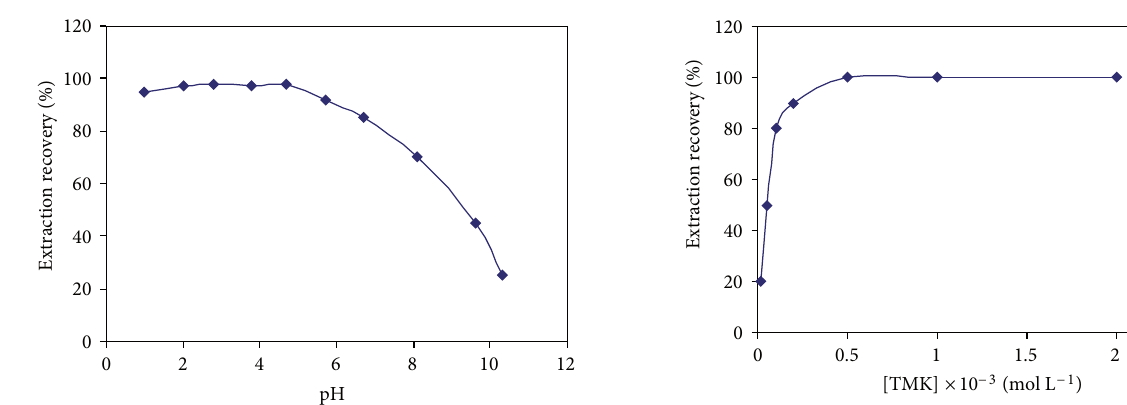
F 2: Effect of TMK on extraction recovery of palladium obtained from DLLME. Extraction conditions: water sample vol- ume, 5.0mL; disperser solvent (methanol) volume,